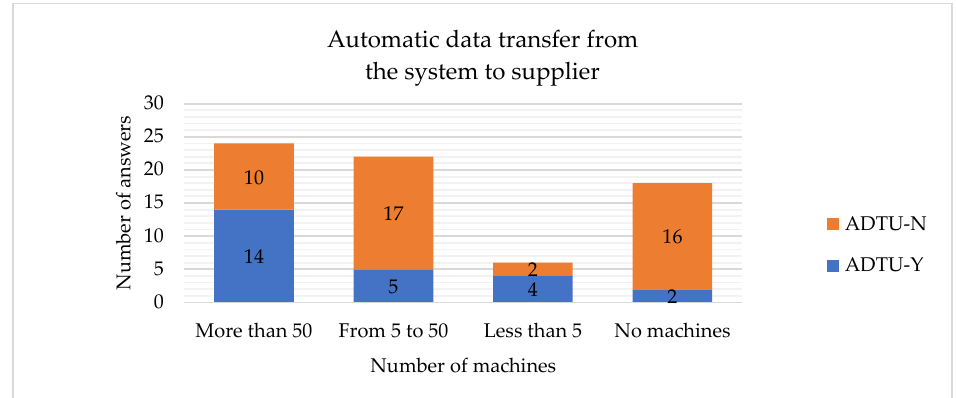
Figure 29. Number of companies having automatic data transfer from the system to supplier implemented (ADTI-Y) or not (ADTI-N) by number of machines.